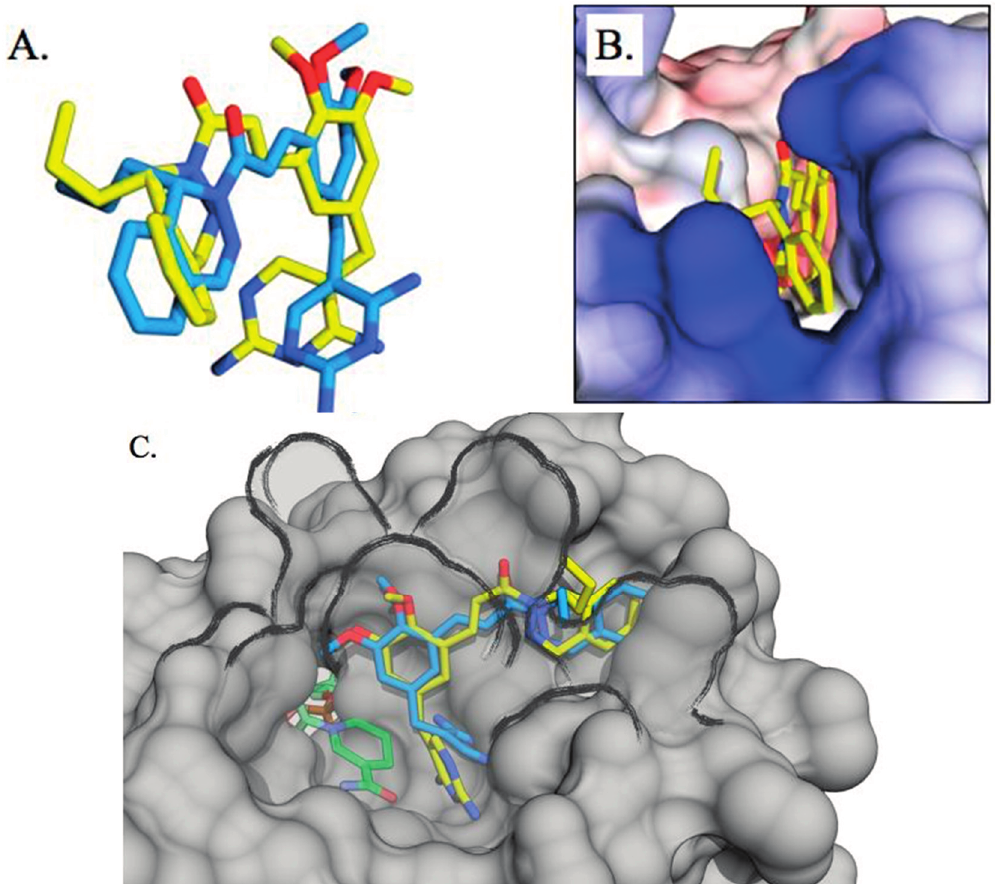
Figure 4. The inhibitor series adopts a low energy conformation prior to binding, and retains this conformation when buried in the DHFR substrate-binding pocket. ( A ) Superposition of ( S )- 3d [( S )-RAB1] from single crystal analysis (cyan) with that observed when bound by the BaDHFR protein (yellow). Note the highly similar conformation, with differences in torsional rotation to optimize the DAP ring placement, and the induced bend of the dihydrophthalazine from planar (cyan) to 107° to 117° (yellow), critical for interactions with the protein site [6]; ( B ) View of ( S )-RAB1 bound in the BaDHFR binding site, with the protein van der Waals surface colored by electrostatic potential; ( C ) Highly buried position of ( S )-RAB1 in the BaDHFR binding site, with part of the protein van der Waals surface shown by outline to permit visualization of the inhibitor (NADPH also visible, green). Note the single crystal (cyan) version of ( S )-RAB1 adopts a highly similar orientation even in the absence of the DHFR protein. Both (B) and (C) illustrate the limited volume for R 1 modifications, with favorable occupancy by up to one ring structure, but extension beyond this results in protrusion into the solvent